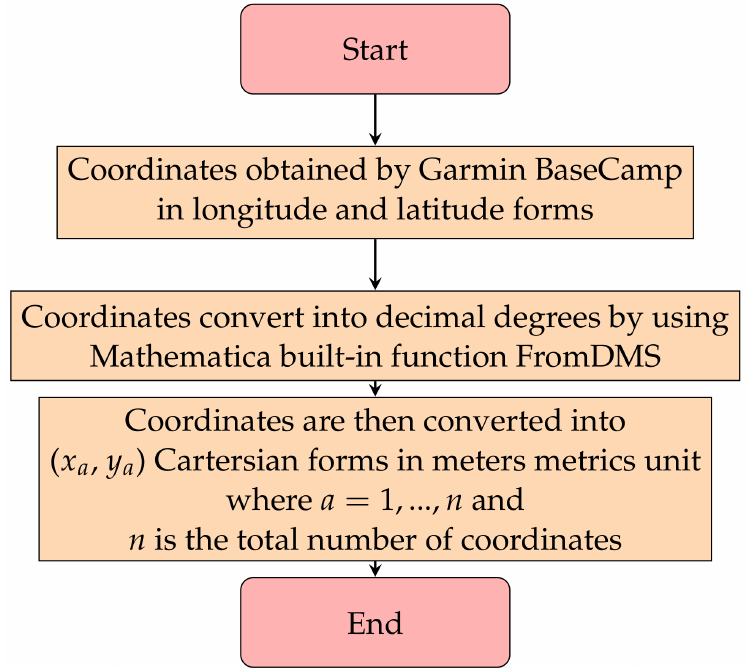
Figure 2. Flowchart for obtaining the coordinates from initial to final points of the routes.